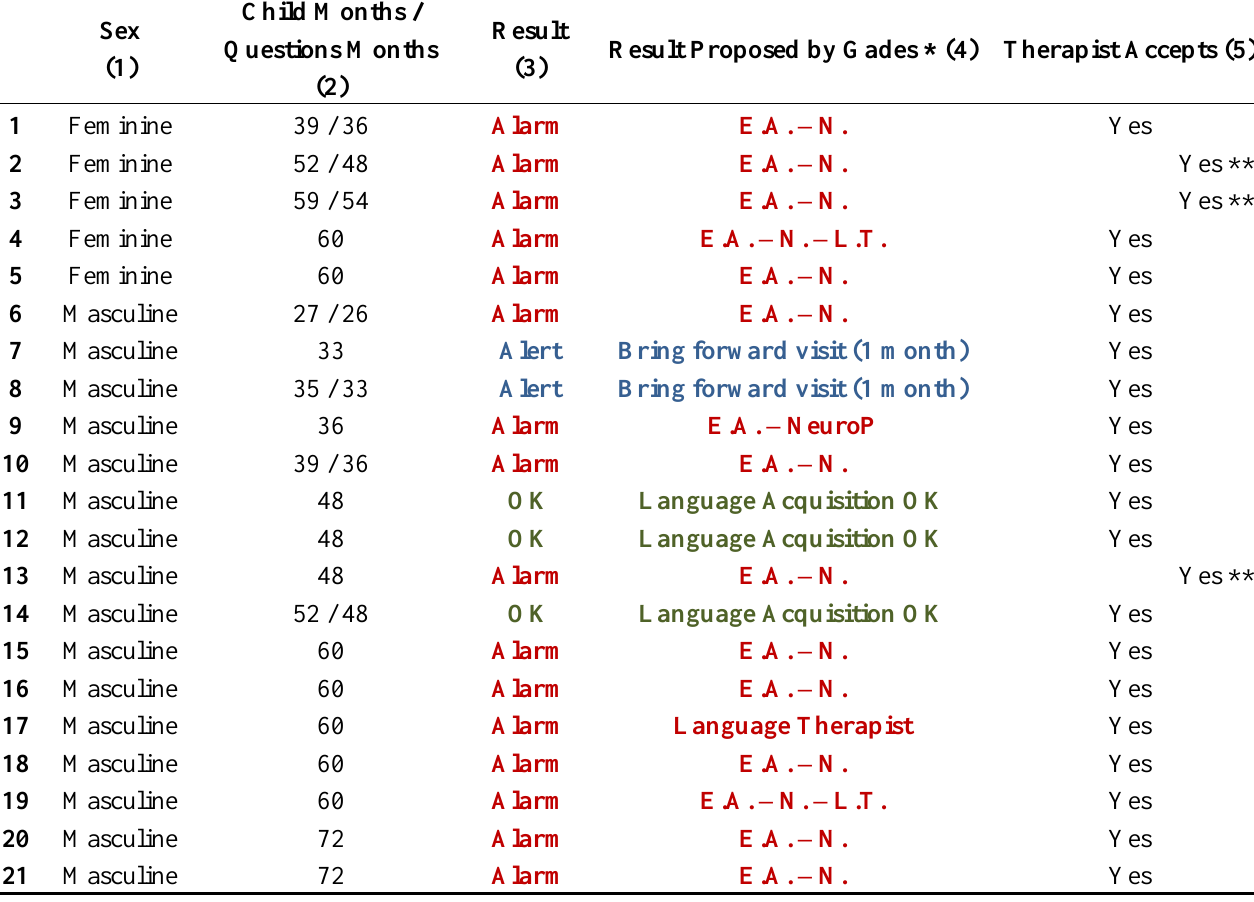
Table 4. Results summary. This table contains a summary of the results obtained in the evaluation